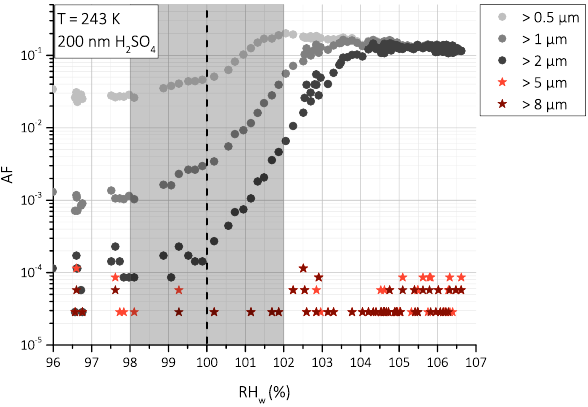
Figure 3. Water droplet (or ice crystal for > 5µm) activation frac- tion and subsequent growth as function of RH w at 243K for 200nm dry diameter H 2 SO 4 particles, shown for all size channels > 0 . 5µm in the OPC. Vertical dashed line represents expected onset for cloud droplet formation; grey area refers to the calculated variation and uncertainty of RH in the aerosol layer.